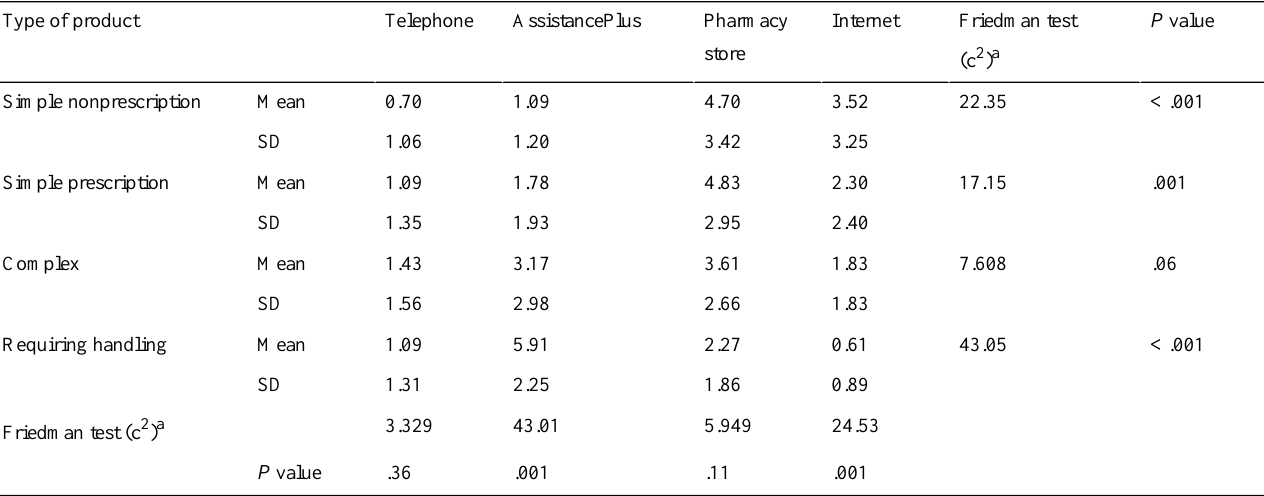
Table 2. Friedman tests on preferences among information channels (N =